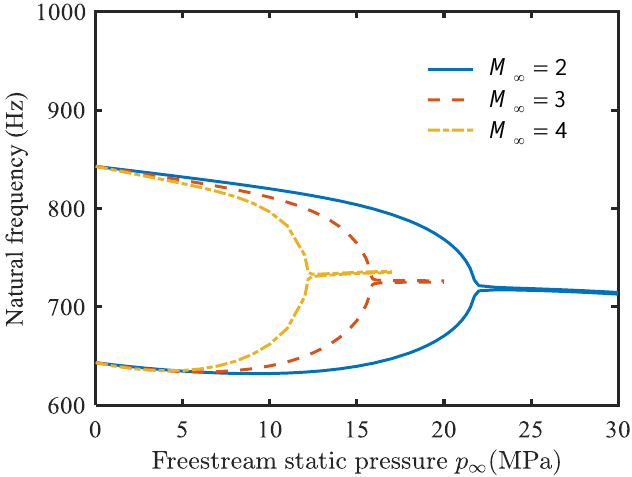
Figure 11. Influence of Mach number on critical free-stream static pressure ( p = 1).